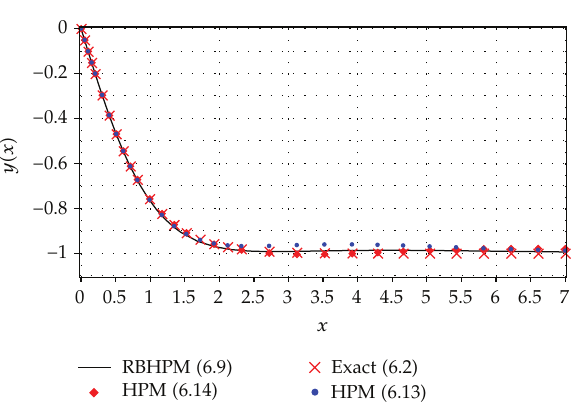
Figure 1: Exact solution (cid:3) 6.2 (cid:4) (cid:3) diagonal cross (cid:4) for (cid:3) 6.1 (cid:4) and its approximate solutions (cid:3) 6.9 (cid:4) (cid:3) solid line (cid:4) , (cid:3) 6.13 (cid:4) (cid:3) solid circles (cid:4) , and (cid:3) 6.14 (cid:4) (cid:3) solid diamonds (cid:4) .